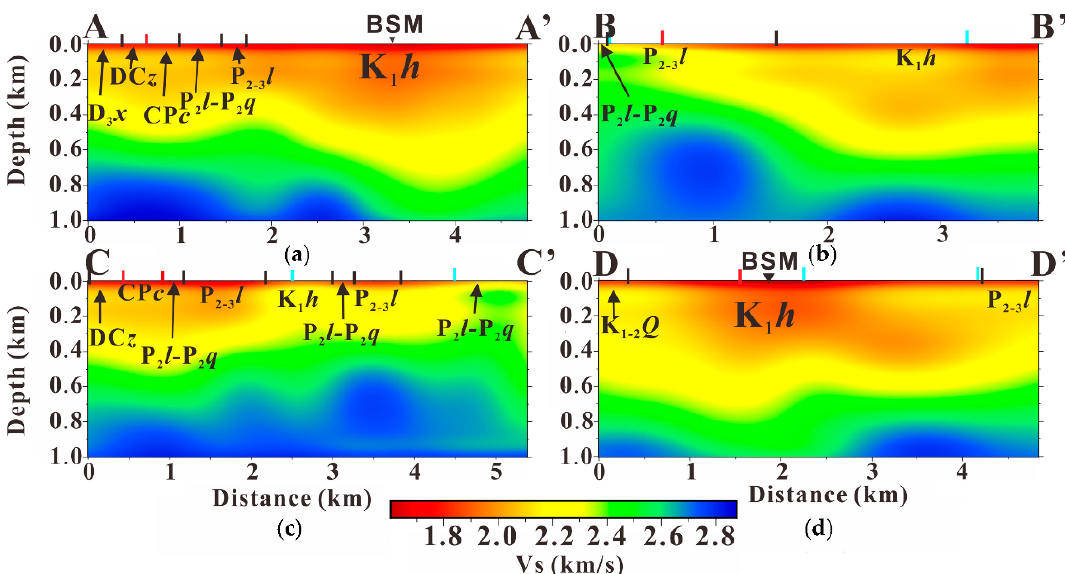
Figure 11. Four profiles are shown to identify the lateral variation of the main structures. The profile locations are plotted in Figure 2. Profile ( a ) goes across the BSM and north syncline. Profile ( b ) crosses the West Lake and the southwestern WLS. Profile ( c ) goes along the trend of the SW synclinorium. Profile ( d ) passes through the BSM and the West Lake. The auxiliary black, cyan, and red solid thick lines on the top of the profiles correspond to the position of the lithologic interfaces, the boundaries between the land and the West Lake, and fault locations,